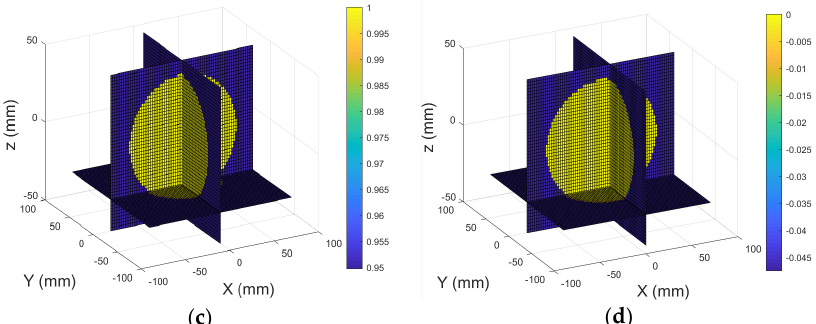
Figure 4. 3D view of the heal model contains unit relative permittivity: ( a ) Real part; ( b ) Imagery part; 3D reconstructed images: ( c ) Real part; ( d ) Imagery part.